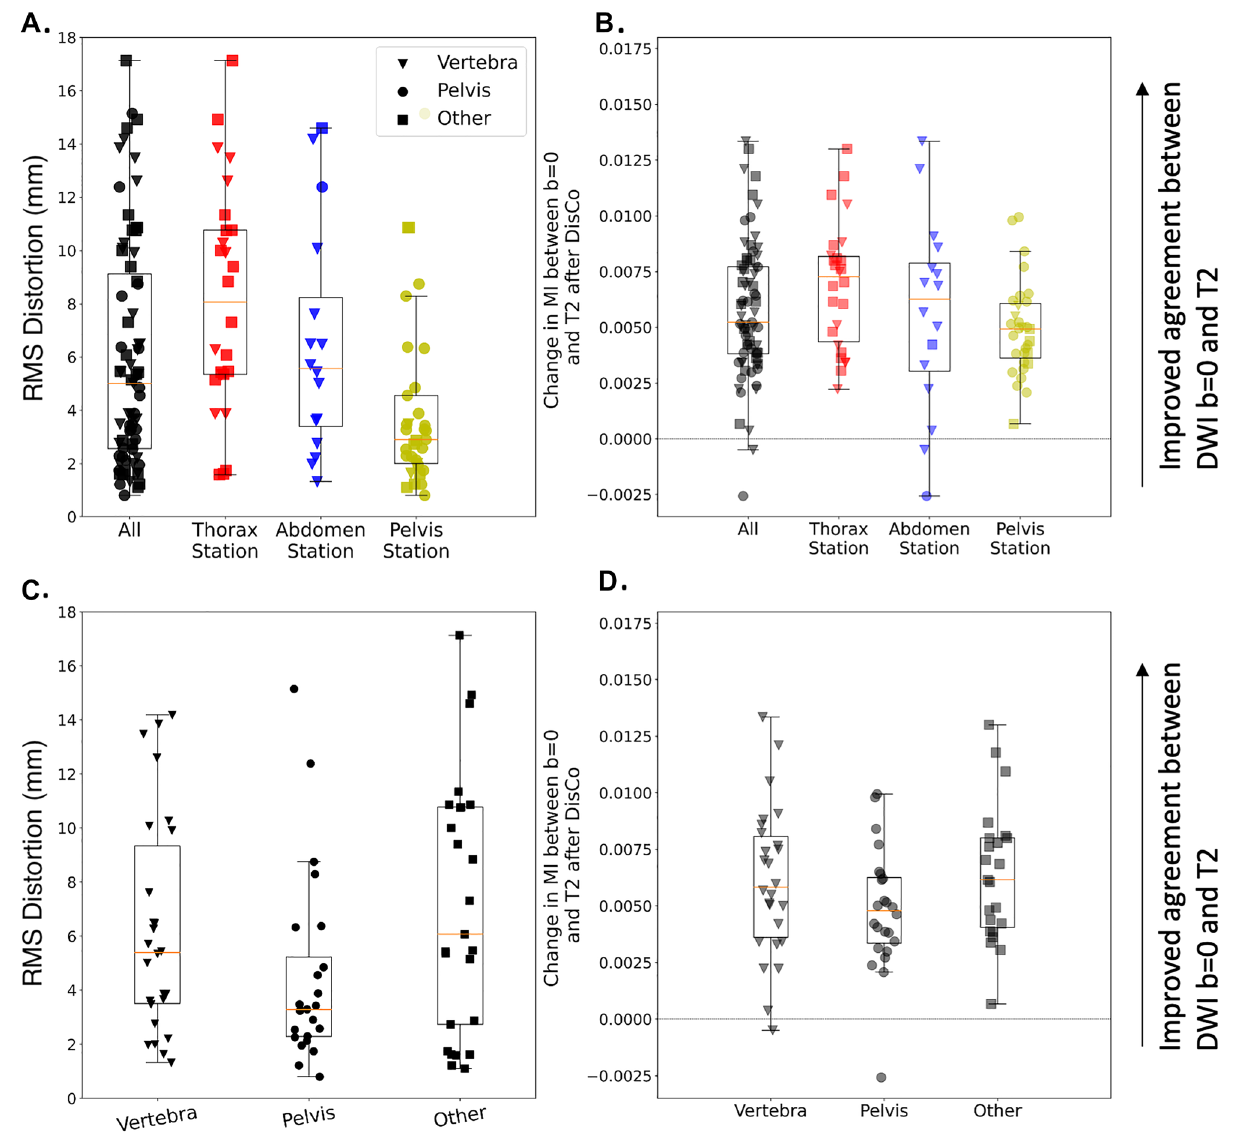
Distortion for lesions across all stations (black) as well as the distribution within specific imaging Stations (red, blue, and yellow). Distortion was estimated by calculating the RMS of the values in the distortion map that correspond to the lesion annotation and immediately surrounding areas (see Eq. (1)). ( B ) Change in MI values between the DWI b = 0 s/mm 2 and T2-weighted images after DisCo. A value larger than 0 indicates improved agreement between DWI b = 0 s/mm 2 and T2-weighted images. Again, we plot the distribution for all lesions as well as the breakdown for different Stations. ( C ) For illustrative purposes, we categorized lesions into three distinct anatomic groups: Vertebra, Pelvis, and Other. The Other category represents lesions in bones such as the clavicle, sternum, and femur. The distribution for distortions for each anatomic group is plotted. ( D ) Change in MI values between the DWI b = 0 s/mm 2 and T2-weighted images after DisCo broken down by anatomic group. DisCo led to consistent increases in similarity between DWI b = 0 s/mm 2 and T2-weighted images. RMS root mean square, MI mutual